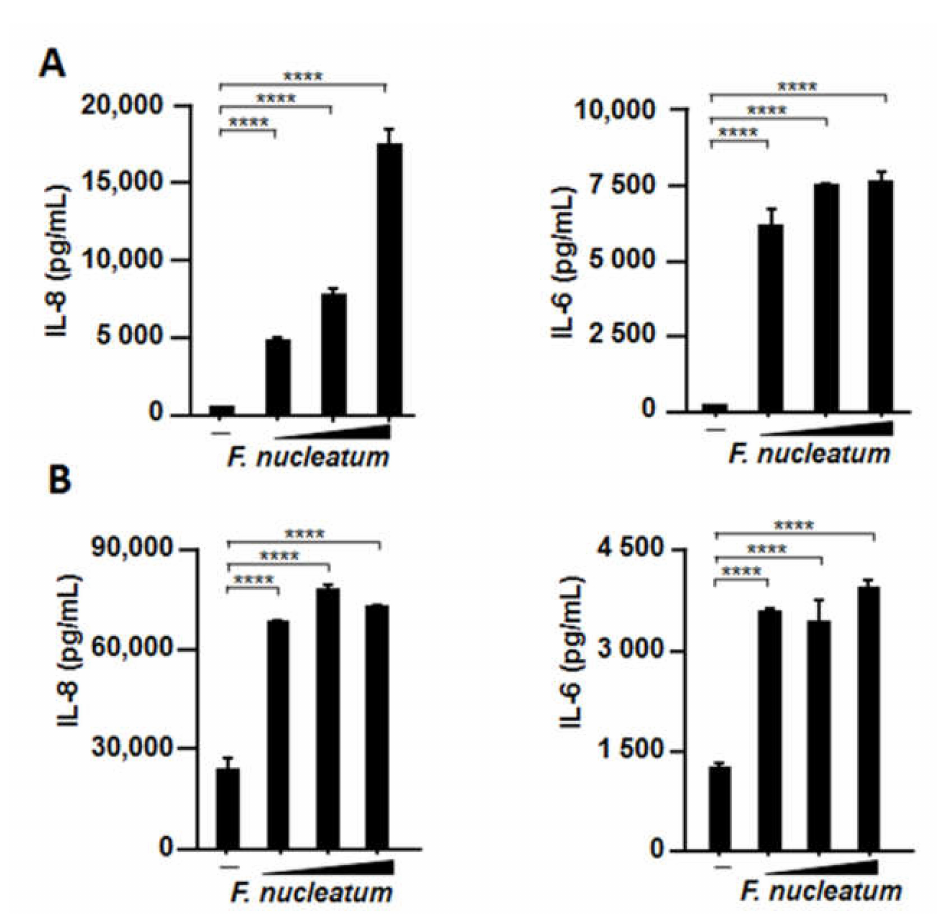
Figure 4. Effects of CSF on IL-8 and IL-6 production by two human respiratory epithelial cells. Human bronchial (BEAS-2B) ( A ) and pharyngeal (Detroit 562) ( B ) epithelial cells were incubated with CSF (25, 50, or 100 µ L/mL) for 48 h. IL-8 and IL-6 protein levels in the cell culture supernatants were in triplicate, and data are presented as the mean ± SD; n = 3 (****, p <